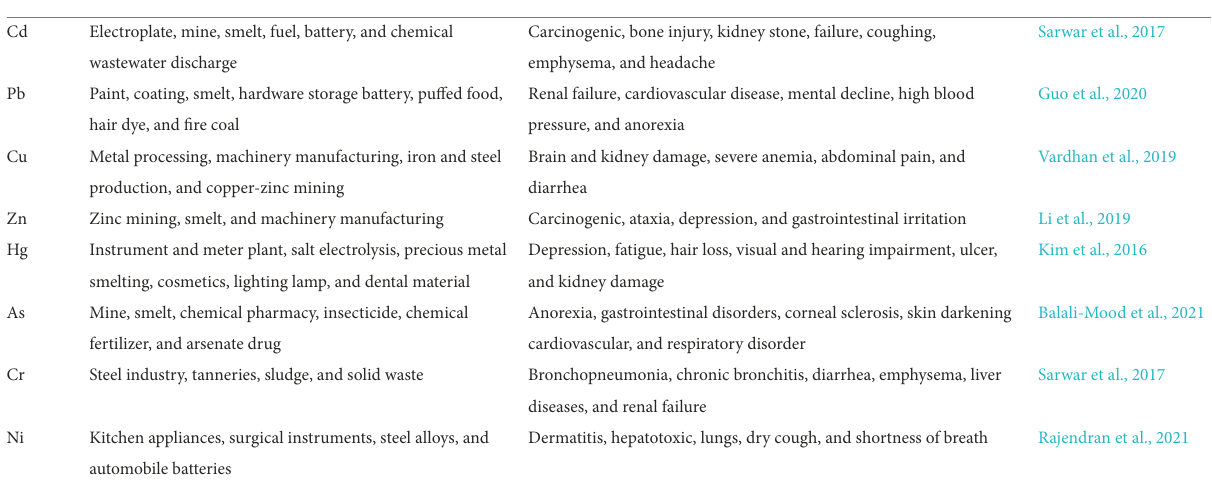
TABLE 1 The sources and harmful effects of